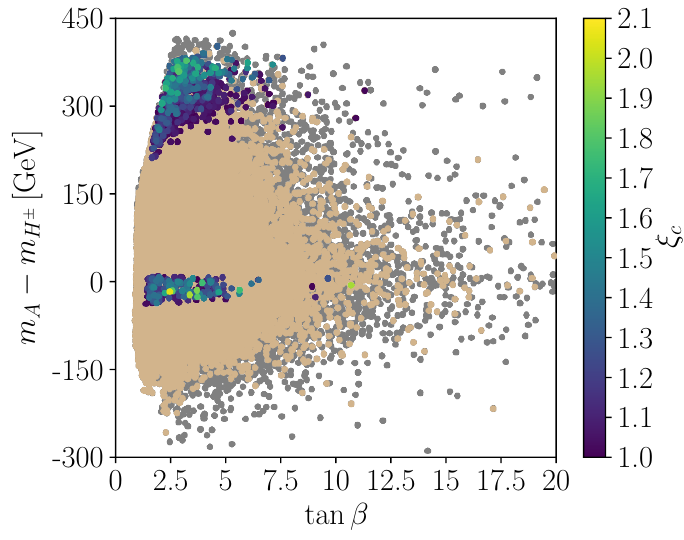
Figure 5 . N2HDM T1: the mass di(cid:11)erence m A as in (cid:12)gure 3. The di-Higgs search constraints are included. (cid:12)gure 4(b) where the charged mass m coding as in (cid:12)gure